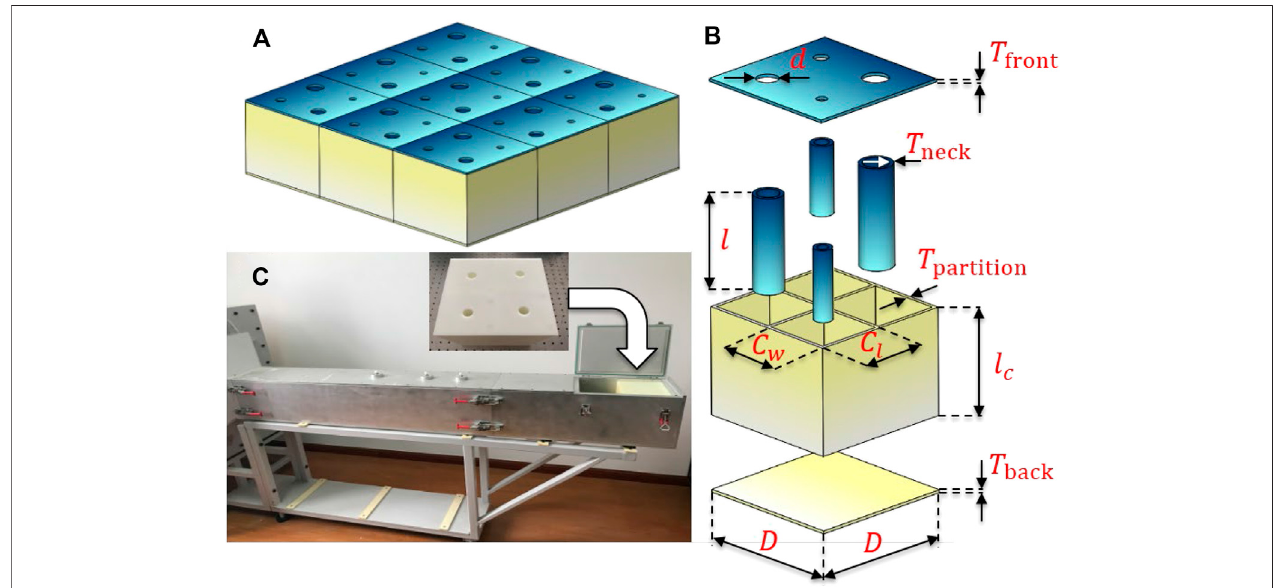
FIGURE1|(A) Schematicofametasurface absorber withnine supercells. (B) Theexplosiveviewofonesupercellwithfour differentunit cells.The thickness ofthe frontpanel, T front ,thethicknessesofthenecks ’ walls, T neck ,andthethicknessesofpartitions, T partition ,areallsetas5 mm,accordingtoourexperimentaltrials,tomitigate the coupling effect betweenneighboring airdomains throughthe shared partitions sothatthe assumption ofacoustically rigid boundaries inthe analytical and numerical modelsisgenuinelyvalid.Thethicknessofthebackpanel T back ,is2 mm.Thediameteroftheneckis d ,thelengthoftheneckis l n (cid:1) l + T front ,thelateralsizeofaunit cell is S ( C w × C l ) , the length of the cavity is l c , and the side length of a supercell is D . (C) The photograph of the experimental set-up for measuring absorption using the two microphones method. The lateral size of the impedance tube is 20 cm × 20